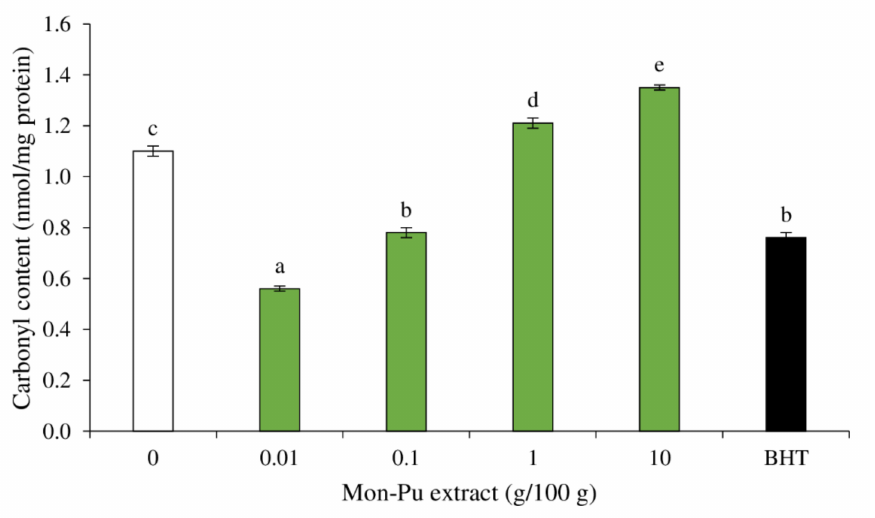
Figure 4. Effect of Mon-Pu leaf extract (MPE) on protein oxidation measured by carbonyl content of a cooked sausage model system (SMS). Butylated hydroxyl toluene (BHT) at 0.003% was used to compare. Bars represent the standard deviations from triplicate determinations. Different letters indicate the significant differences ( p <